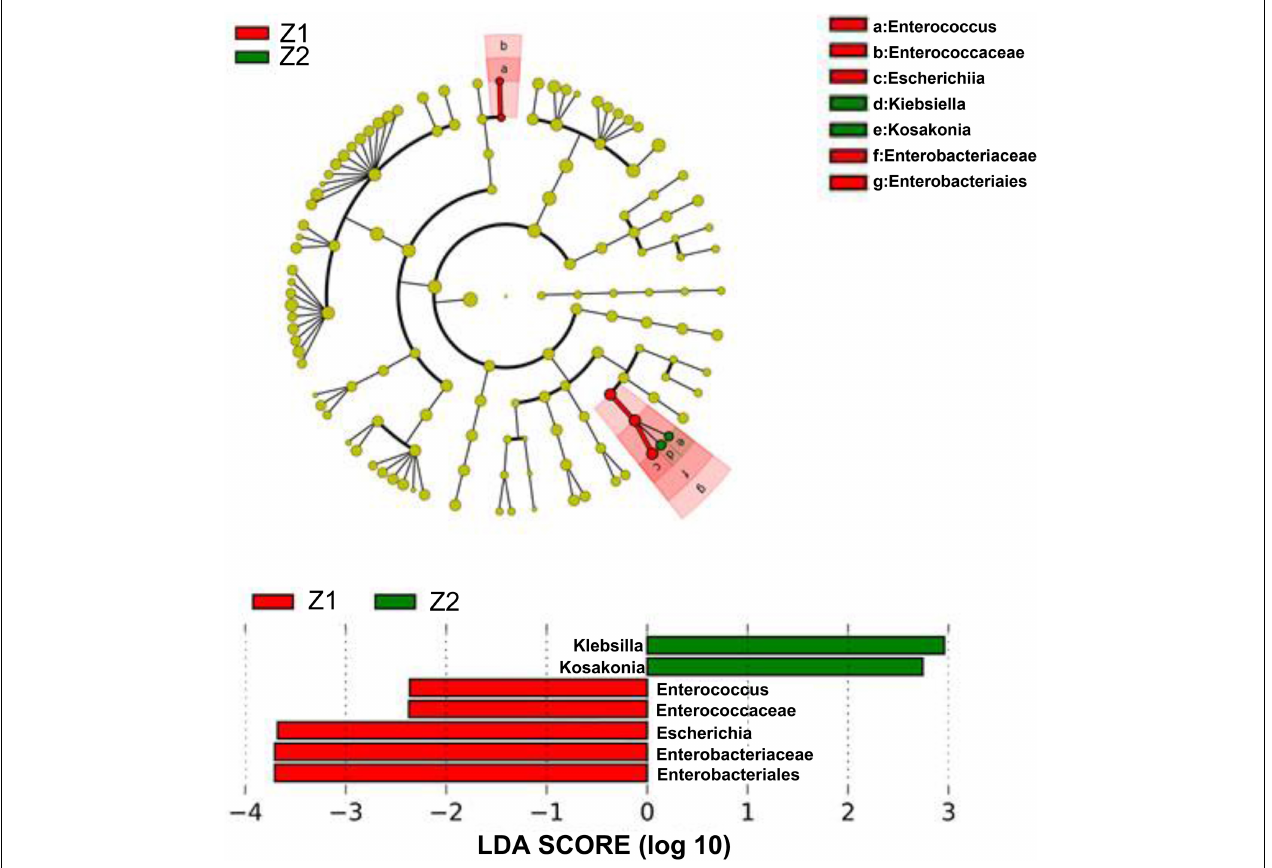
FIGURE 7 | Species differences of intestinal flora in the patients in the Electroacupuncture group and the Control group (Z1, the Electroacupuncture group before treatment; Z2, the Electroacupuncture group after treatment; D1, the Control group before treatment; D2, the Control group after treatment).